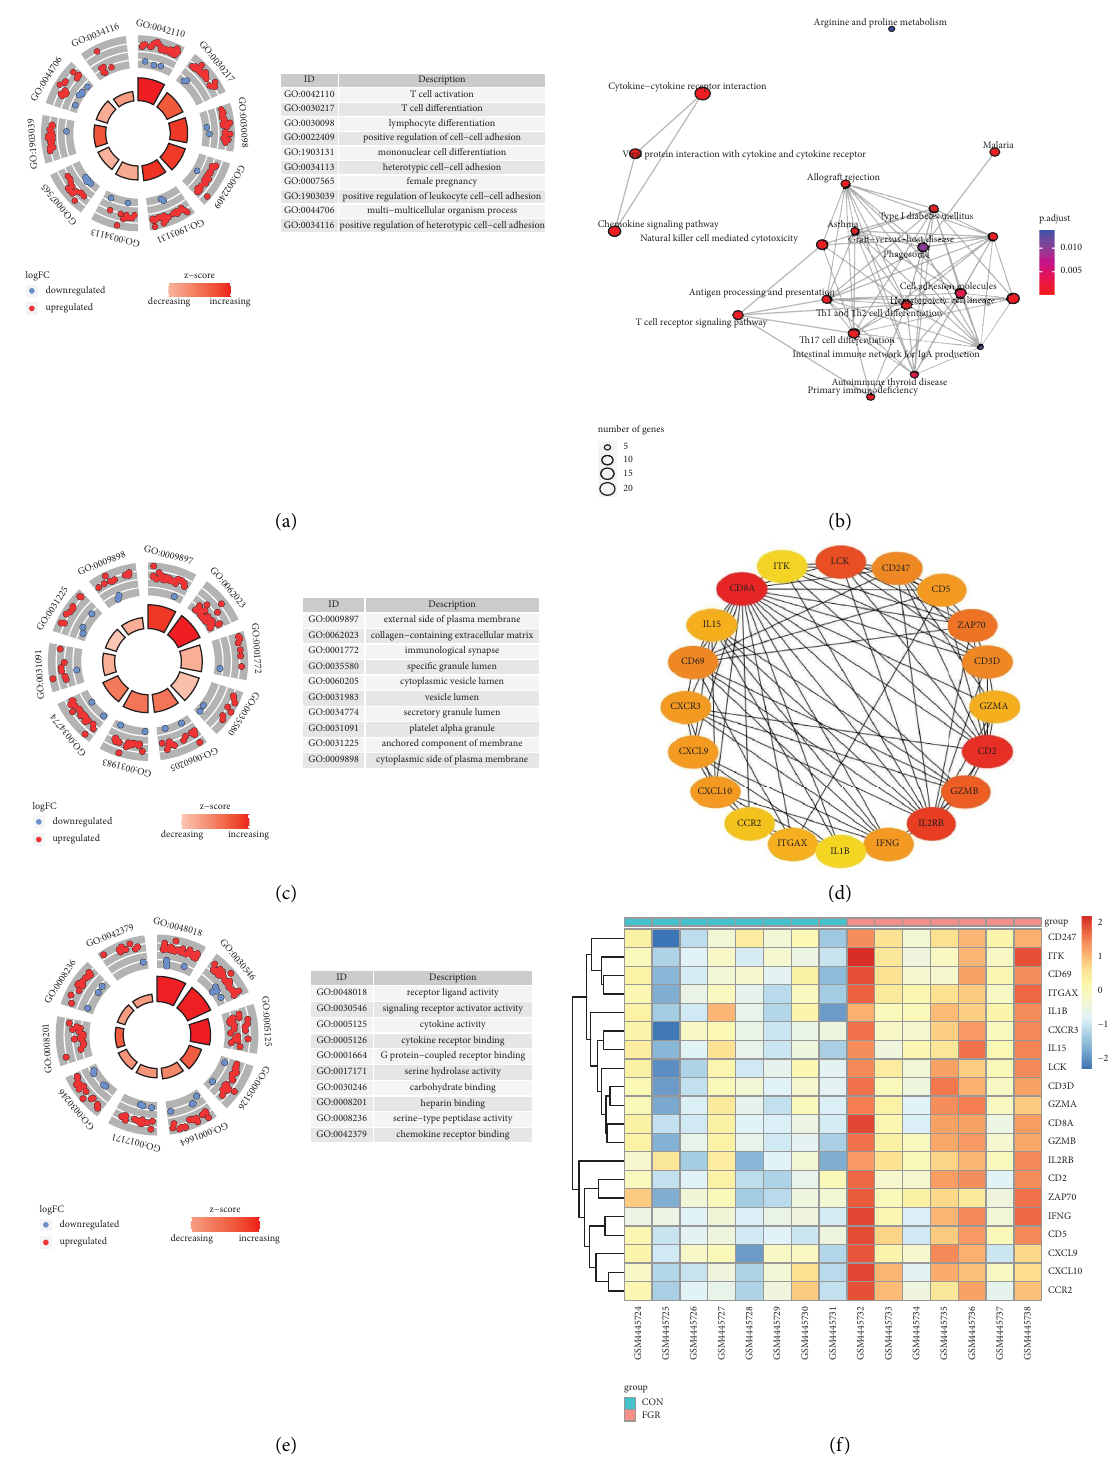
Figure 5: Functional analysis of the hub genes. (a) Biological process analysis. (b) KEGG pathway analysis. (c) Cell component (CC) enrichment analysis. (d) PPI network between 20 core genes. (e) Molecular function analysis. (f) Heatmap of 20 core